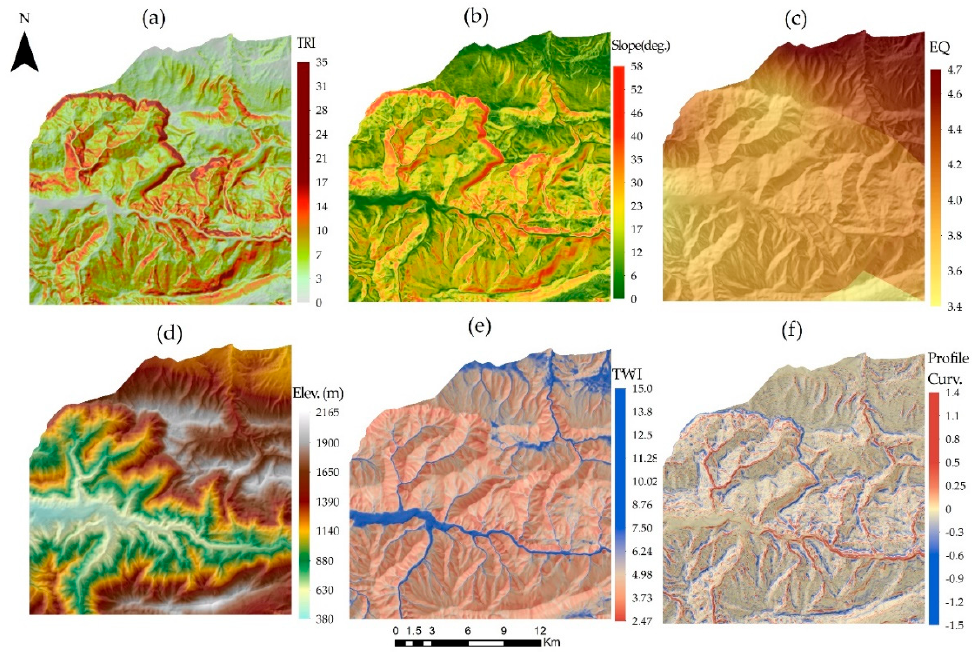
Figure 6. The layers of the top influential factors that control landslide susceptibility in the protected forest in NE Iran: terrain ruggedness index (TRI) ( a ); slope ( b ); earthquake (EQ) ( c ); elevation (Elev.) ( d ); topographic wetness index (TWI) ( e ); and profile curvature (Profile Curv.) ( f ).